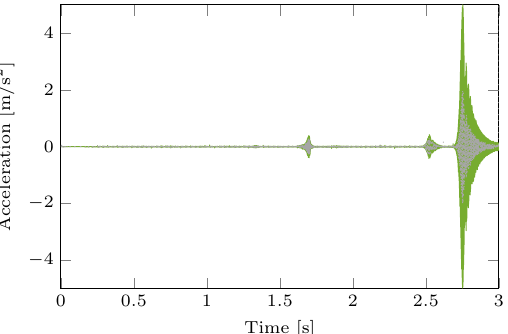
Figure 9. Vertical acceleration of point T : comparison between Subs-c and FiLm method.